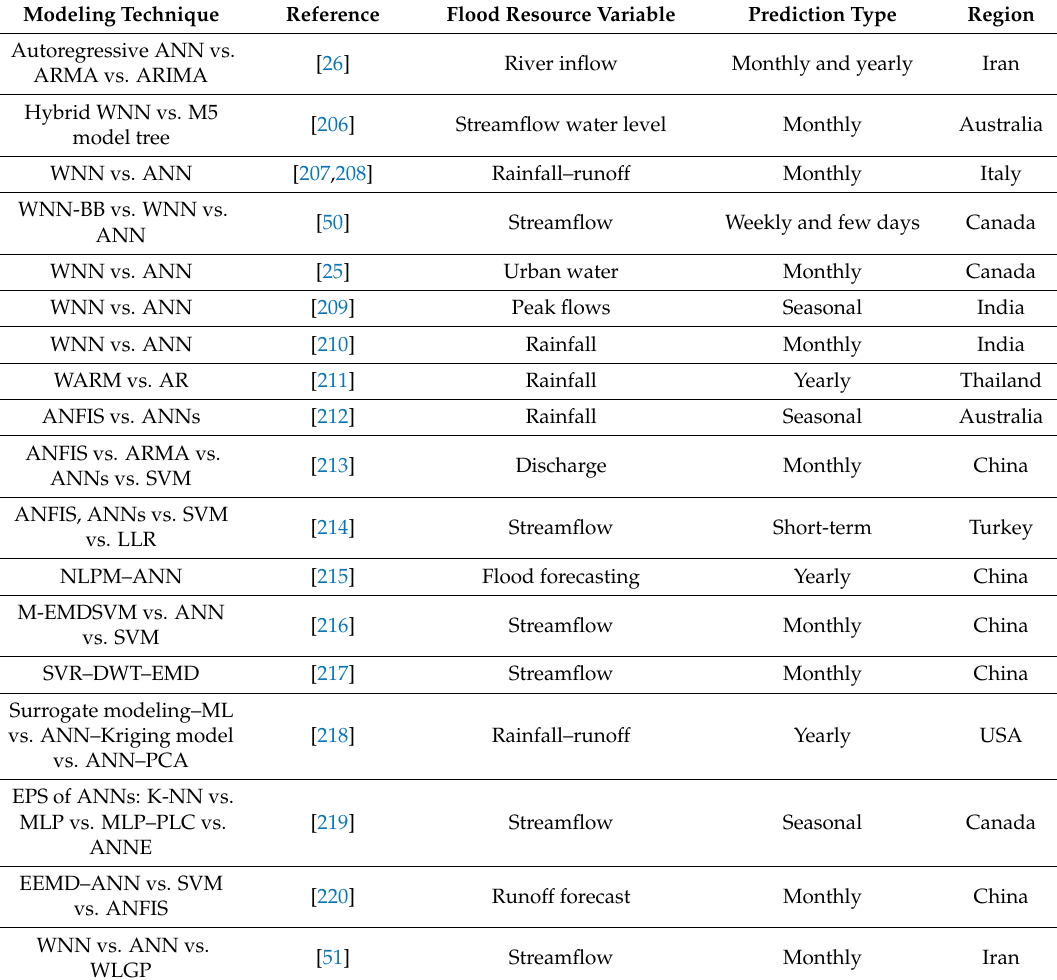
Table 6. Long-term flood prediction using hybrid